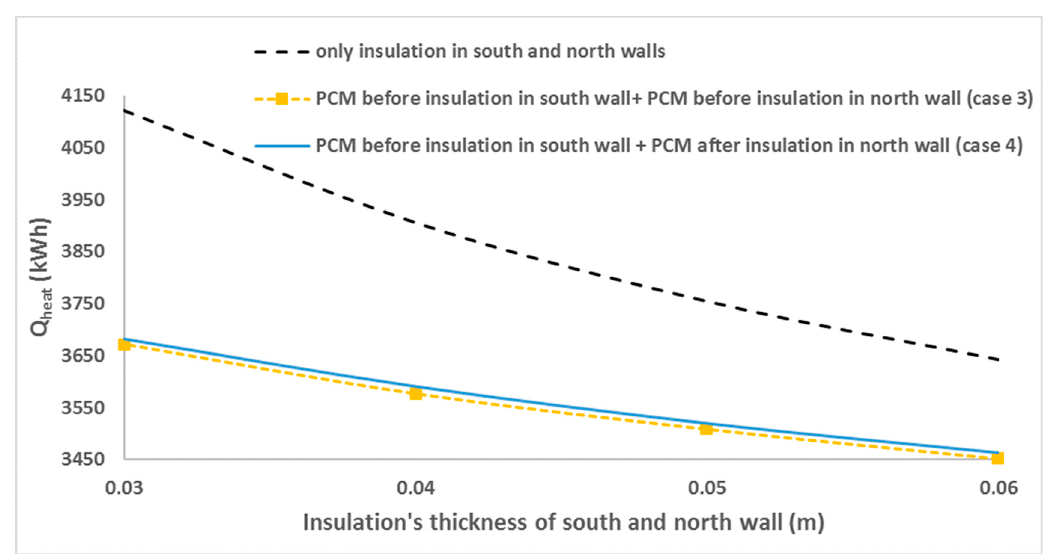
Figure 8. Annual heating loads with PCM in two walls for different insulation scenarios.